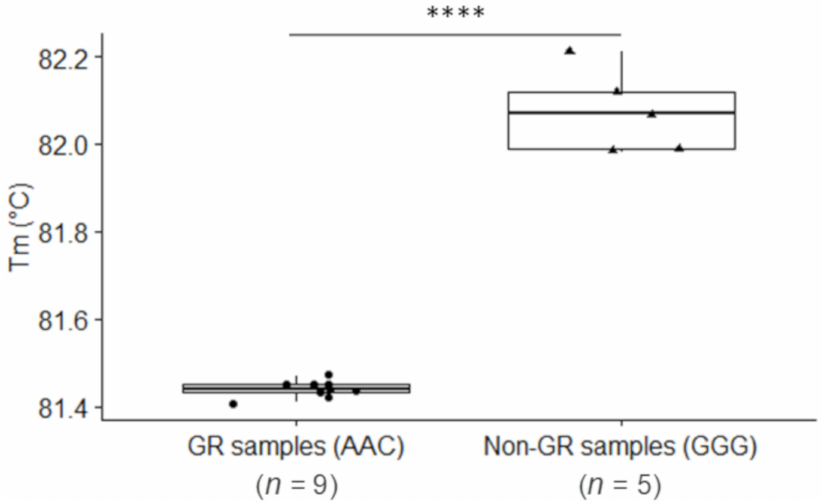
Figure 2. Differences between the melting temperatures (Tm) of samples forming two distinc- tive groups according to the denaturation profiles, showing a statistically significant difference (**** p = 9.67 × 10 − 5 , CI: − 0.75 to − 0.51 ◦